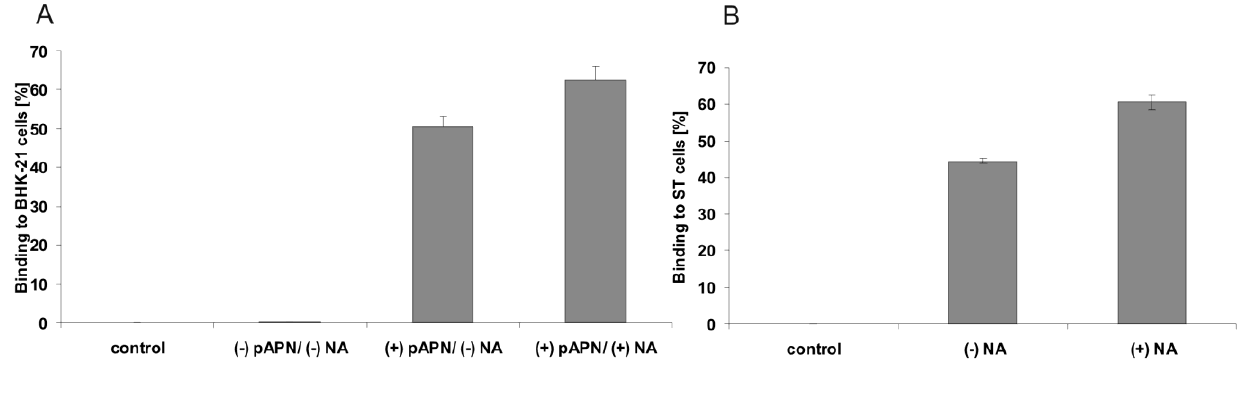
Figure 4. FACS analysis of soluble TGEV spikes bound to BHK-21 cells (A) and ST-cells (B). Binding was only detectable on BHK-21 cells expressing APN. A neuraminidase pre- treatment of the cells revealed an increased binding on both cell lines.